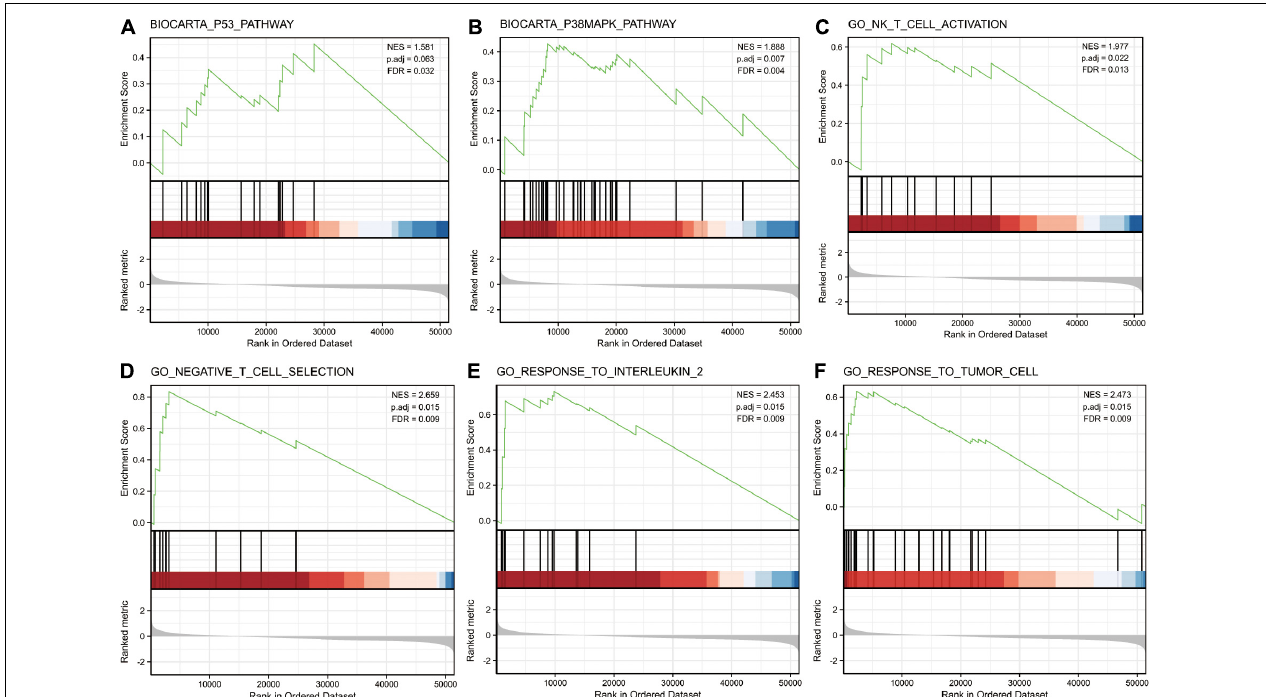
FIGURE 3 | Enrichment plots from gene set enrichment analysis (GSEA). GSEA results showing P53 pathway (A) , P38MAPK pathway (B) , NK T cell activation (C) , negative T cell selection (D) , response to interleukin 2 (E) and response to tumor cell (F) are differentially enriched in miR-3614-5p-related CRC. NES, normalized ES; p.adj, adjust p- value; FDR, false discovery